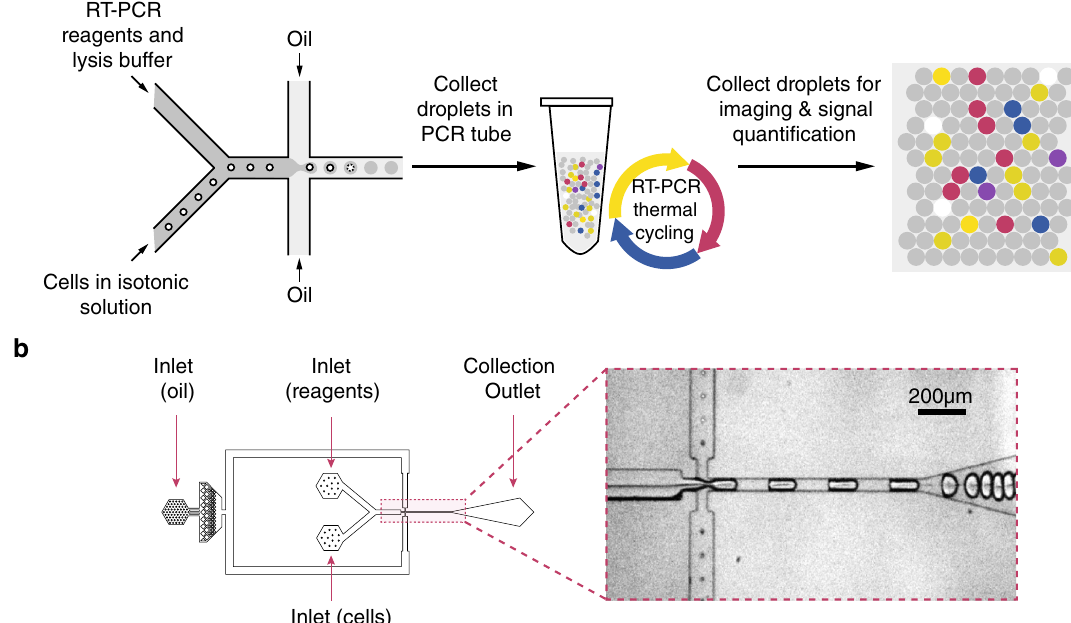
Figure 1. Workflow and devices for droplet-based, single-cell, one-step RT-PCR. ( a ) Process flow of the platform. Cells suspended in an isotonic solution enter a microfluidic device through a channel separate from the RT-PCR reagents and lysis buffer. These channels fuse to a single orifice that injects into a channel met by opposing streams of oil to form monodispersed, 1 nL volume droplets. These droplets are collected in a PCR tube and thermal cycled to generate fluorescent amplification products. The droplets are then deposited in monolayers and analyzed using an automated imaging platform, after which the fluorescent signal in each droplet is quantified. ( b ) Droplet generator design (to scale) and brightfield image of the orifice of the device during droplet